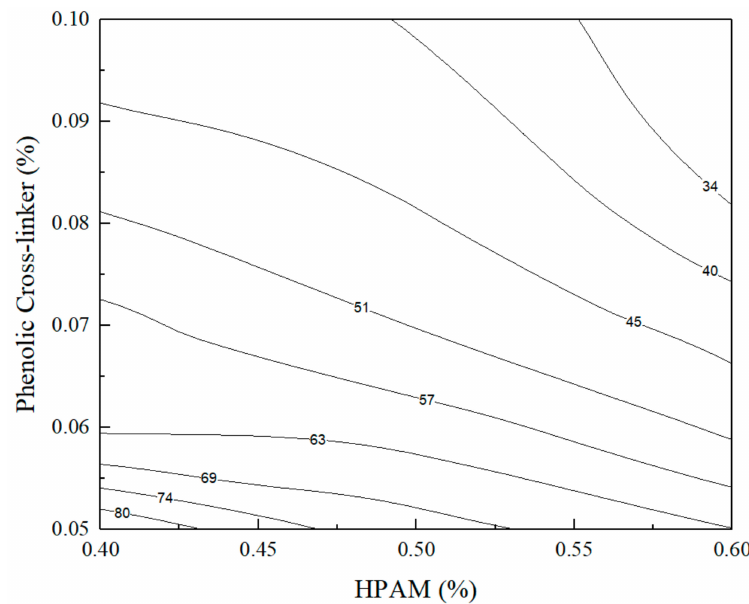
Figure 5. Gelling time of the gel consisting of a polymer (hydrolyzed polyacrylamide; HPAM) and a phenolic cross-linker (100 ◦ C).